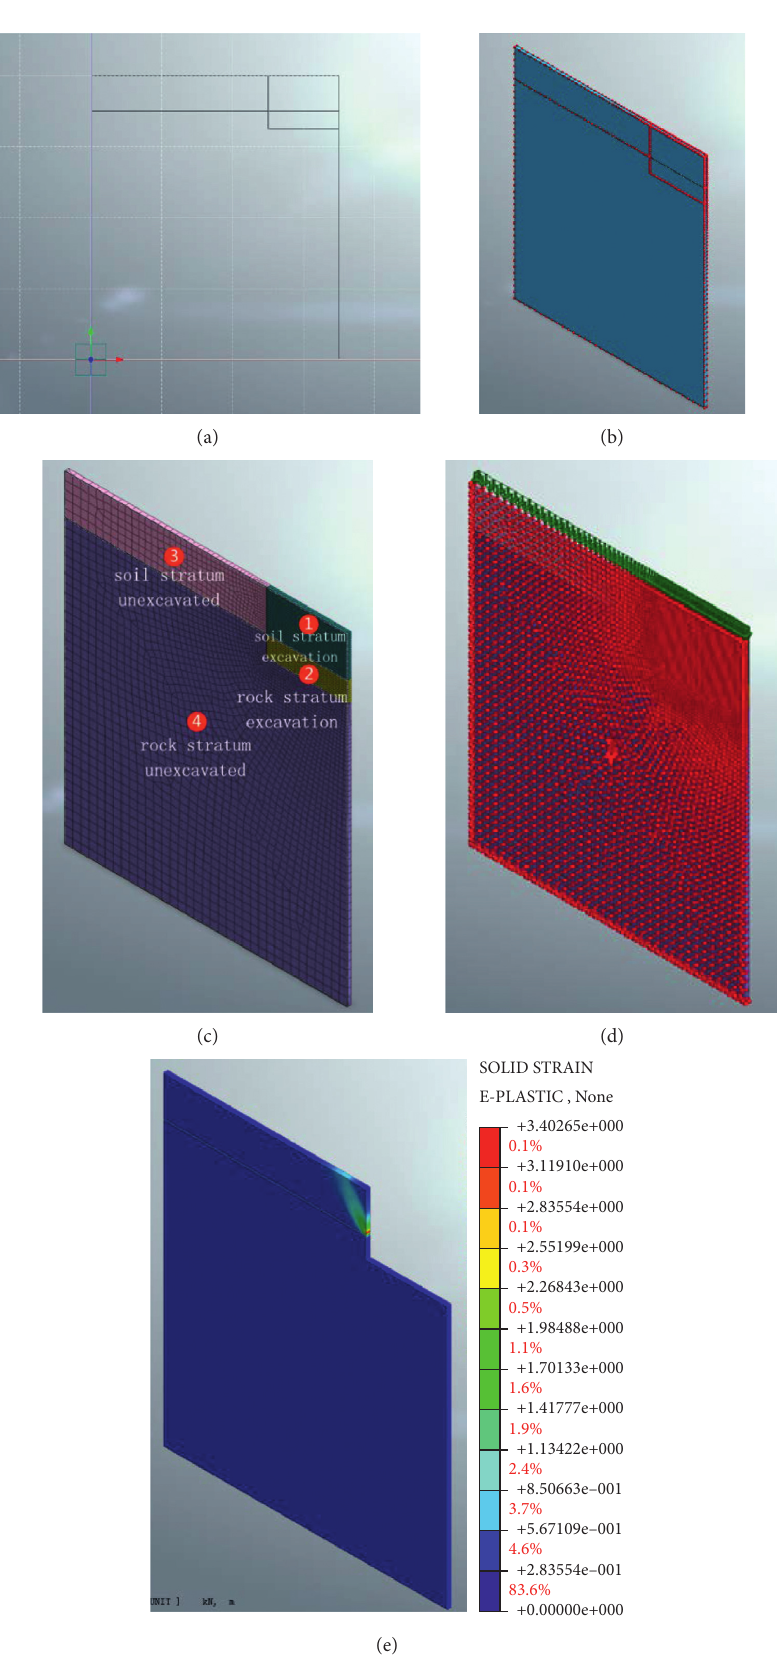
Figure 3: Implementation process of SRM